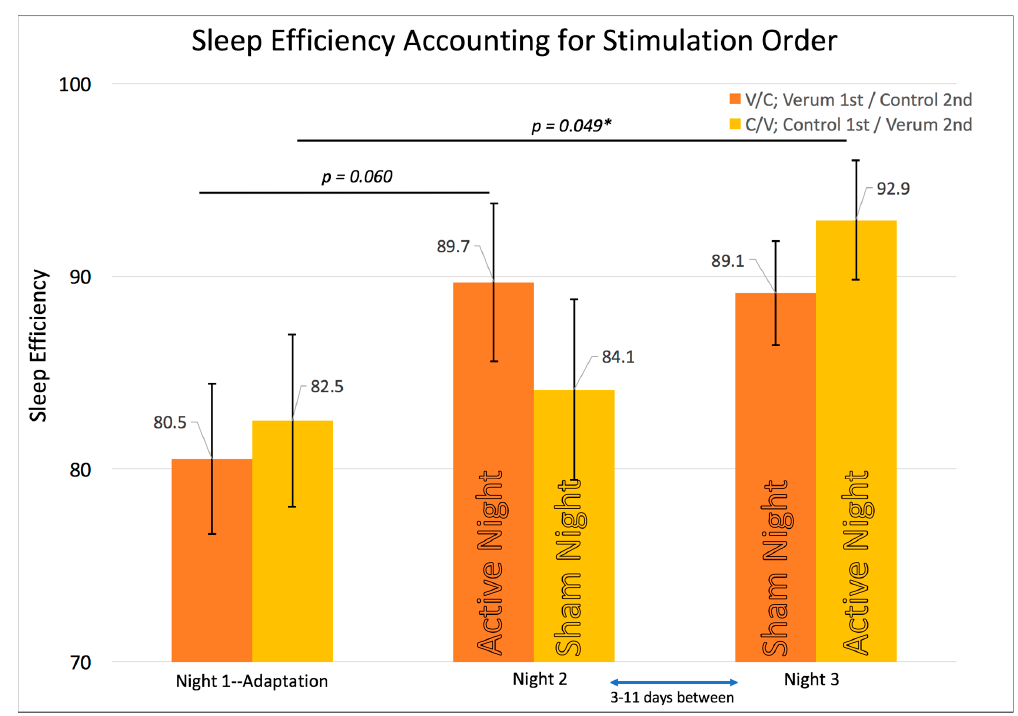
counterbalancing of stimulation condition order. Error bars represent +/- 1 standard error of the mean.